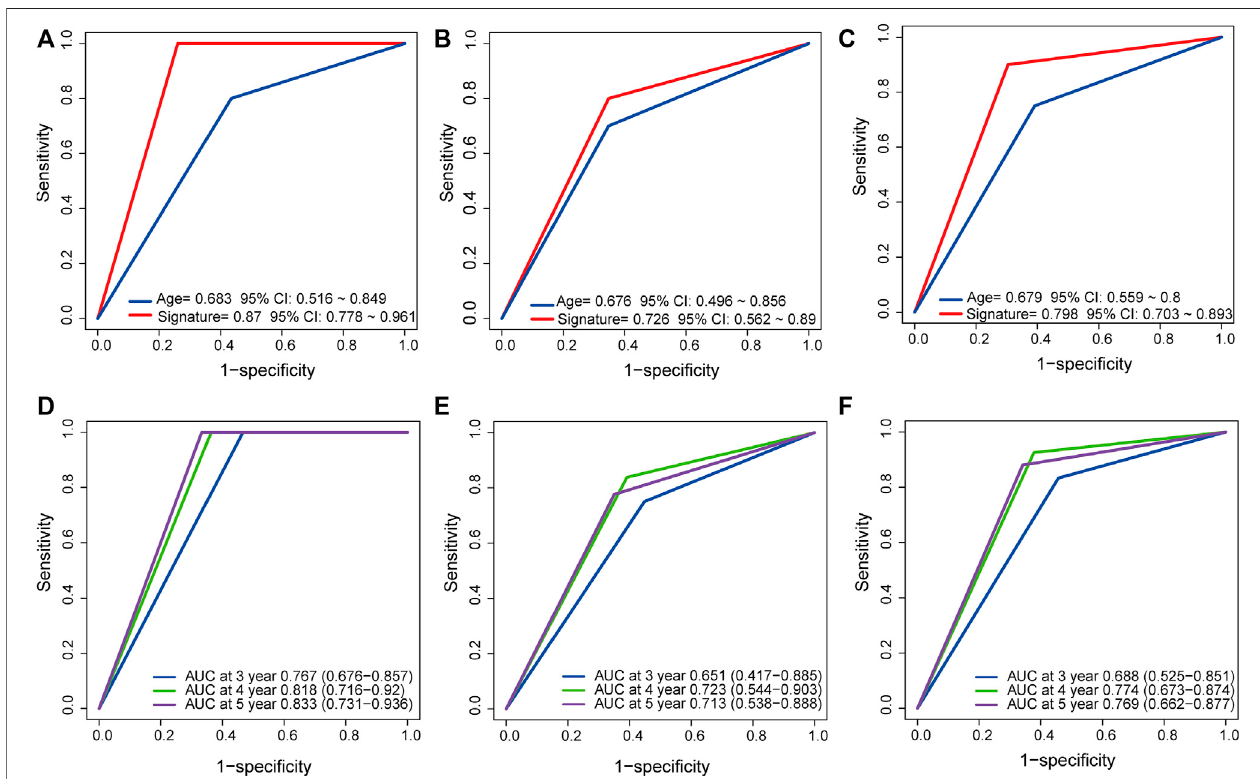
FIGURE5| ComparepredictionpowerofthelncRNAsignaturetothatofAgebyROCinthetraining,test,andentiredataset (A,B,C) andTimeROCanalysisforthe signature at 3,4, and 5 years in the three sets (D, E, F) .